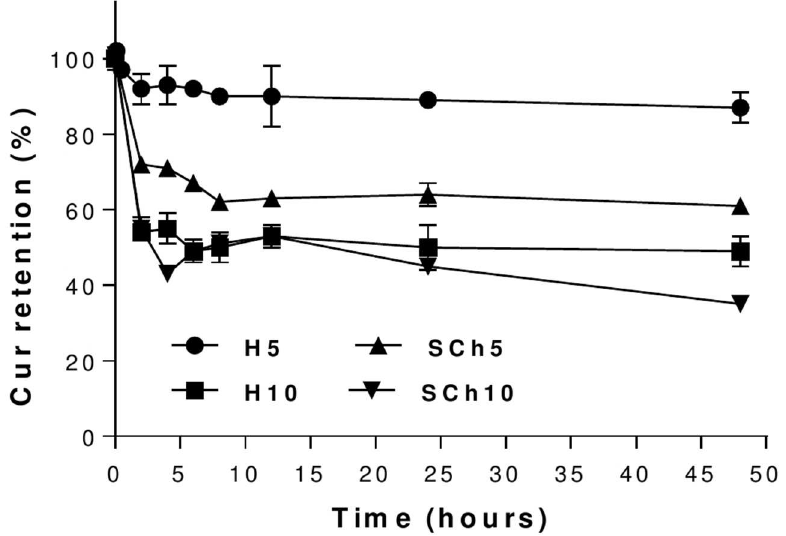
Fig 4. The plasma stability of curcumin-loaded liposomes for the H5, H10, SCh5 and SCh10 formulations. The results are shown as the mean ± SD of three replicates.